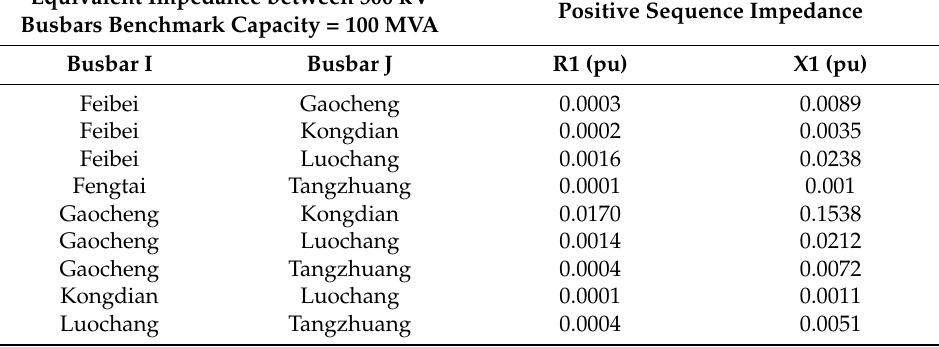
Table 2. 500 kV branch impedance parameters.